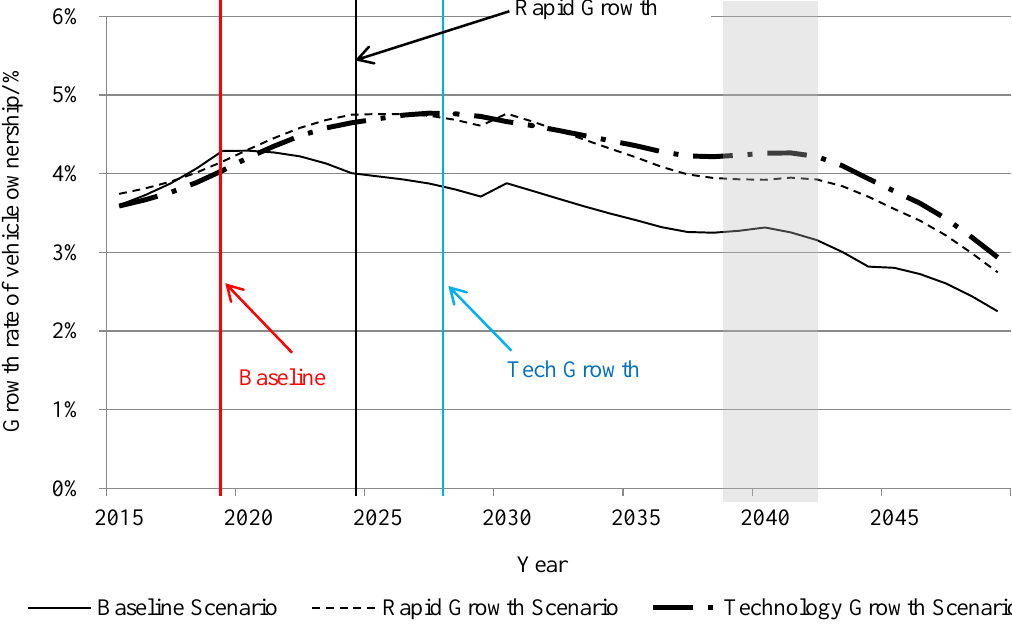
Figure 14. Sensitivity analysis under different GDP growth paths: growth